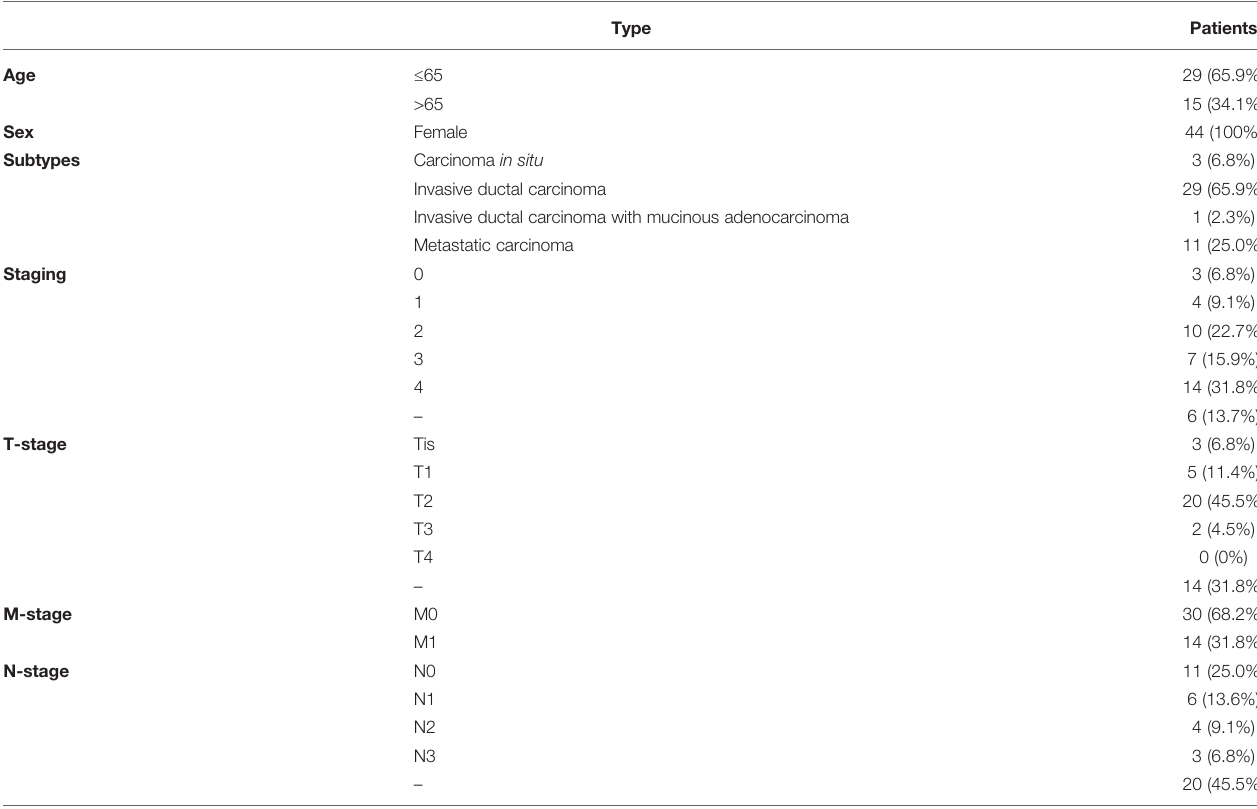
TABLE 4 | The characteristics of 44 breast cancer patients in our